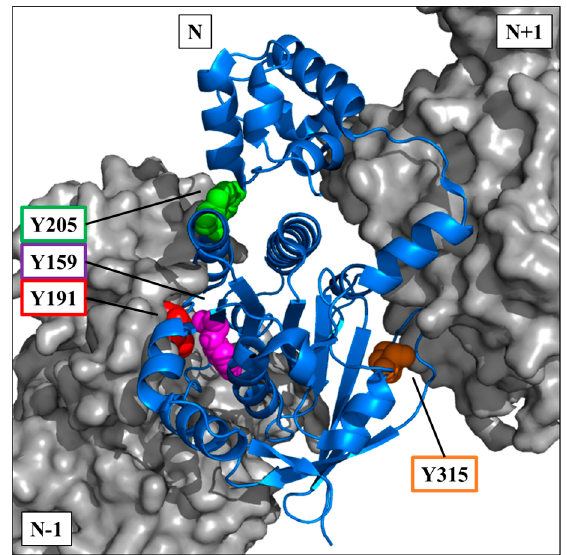
Figure 3. Position of potential phospho-tyrosine residues in the RAD51 filament. Using the PyMOL software and with the nucleofilament structure of RAD51 [24], tyrosines Y159 (magenta), Y191 (red), Y205 (green) and Y315 (orange) of a monomer N of RAD51 (blue—cartoon) are indicated. The monomers N+1 and N-1 are also represented (grey—surface).